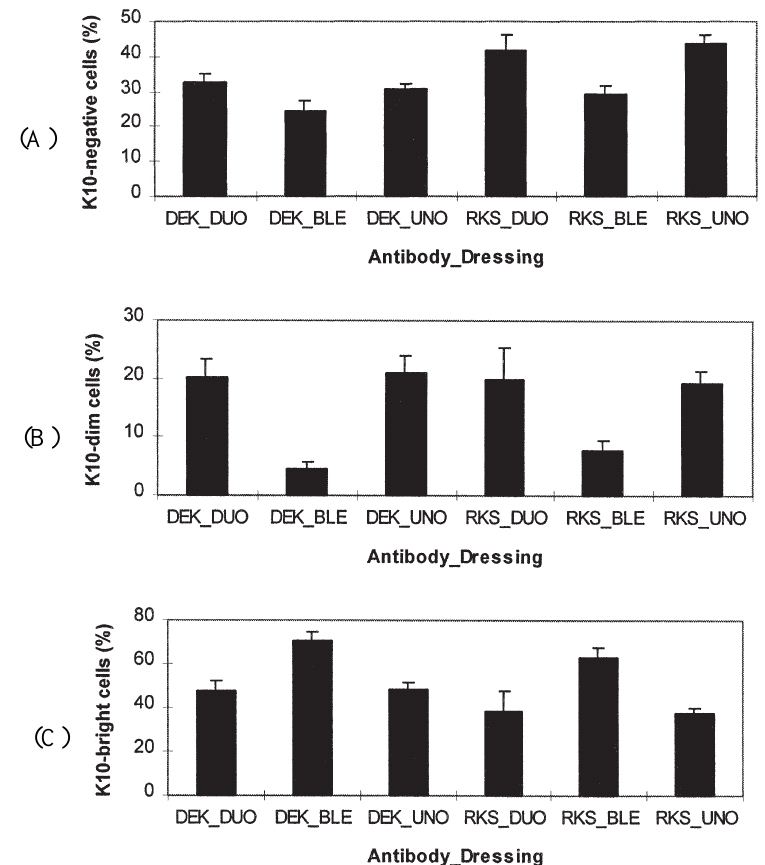
Fig. 2. (A): Percentages of keratin 10-negative cells 48 h following tape stripping; unoccluded (UNO) or after occlusion with Duoderm (DUO) or Blenderm (BLE) measured with RKSE 60 (RKS) and DE-K10 (DEK). (B): Percentages of keratin 10-dim cells 48 h following tape stripping; unoccluded (UNO) or after occlusion with Duoderm (DUO) or Blenderm (BLE) measured with RKSE 60 (RKS) and DE-K10 (DEK). (C): Percentages of keratin 10-bright cells 48 h following tape stripping; unoccluded (UNO) or after occlusion with Duoderm (DUO) or Blenderm (BLE) measured with RKSE 60 (RKS) and DE-K10